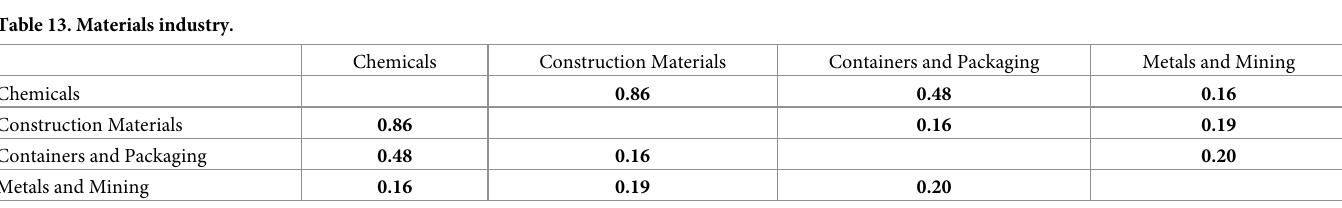
Table 13. Materials industry.